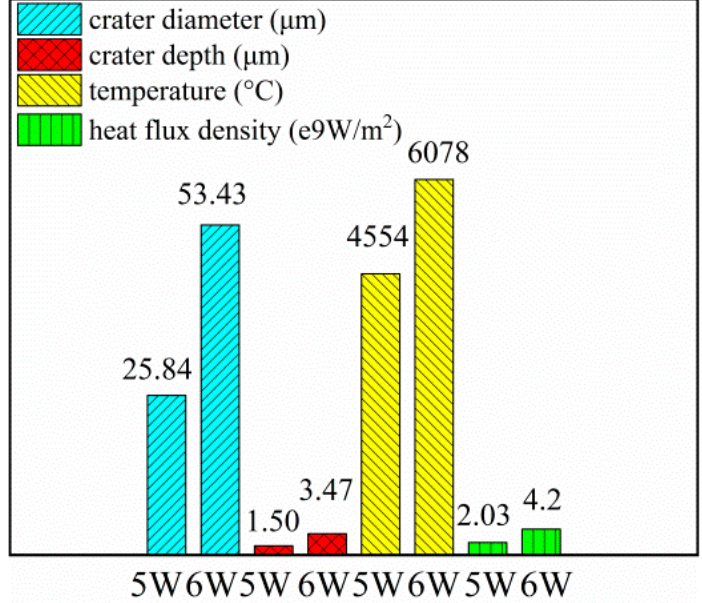
Figure 5. Simulation model versus experimental data trend graph.